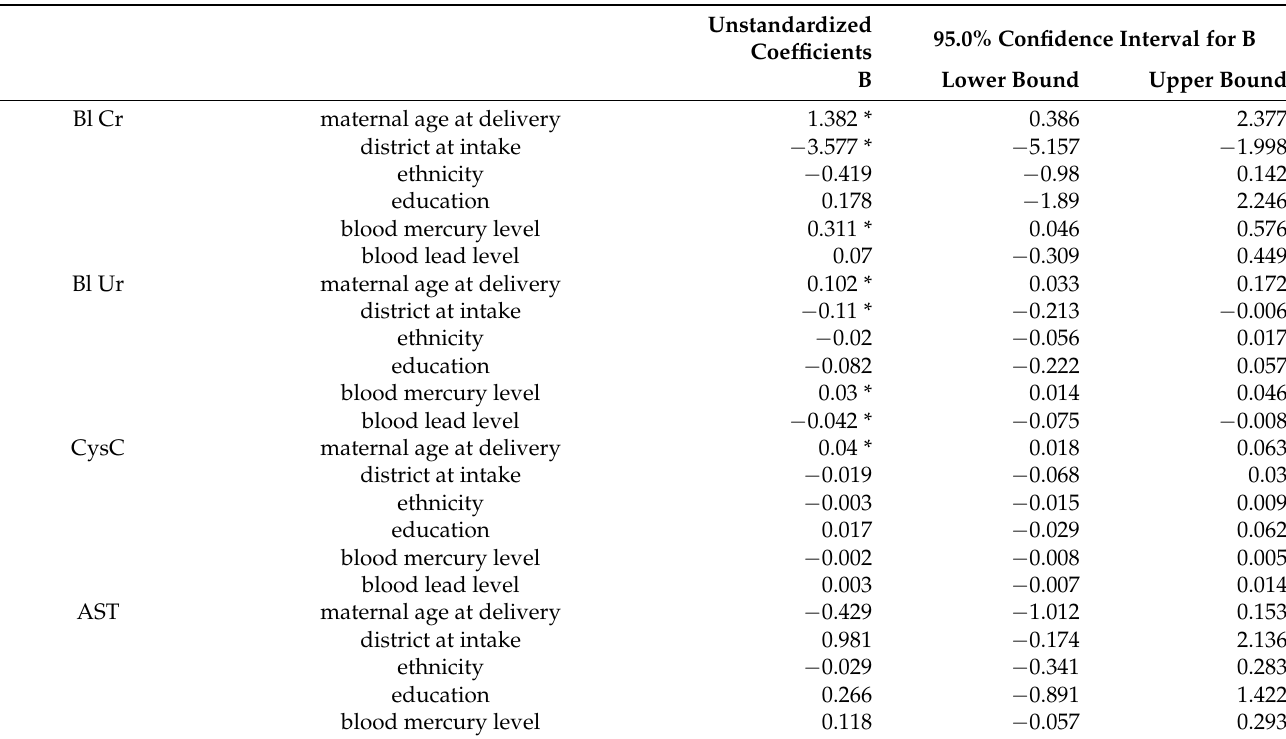
Table 5. Results from the weighted least squares regression analysis examining the relationship between maternal demographic characteristics and heavy metal exposure with the liver and kidney function